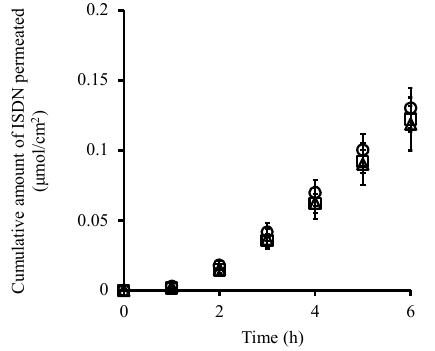
Figure 2. Time course of the cumulative amount of ISDN that permeated through pig ear skin from its solution. pH 3.0 ( ), pH 7.4 ( ) and pH 10.0 ( ). Each point represents the mean ± S.E. ( n = 3–4). Table 2. Skin permeation parameters of ISDN from solutions with different pH. Skin Permeation Parameter